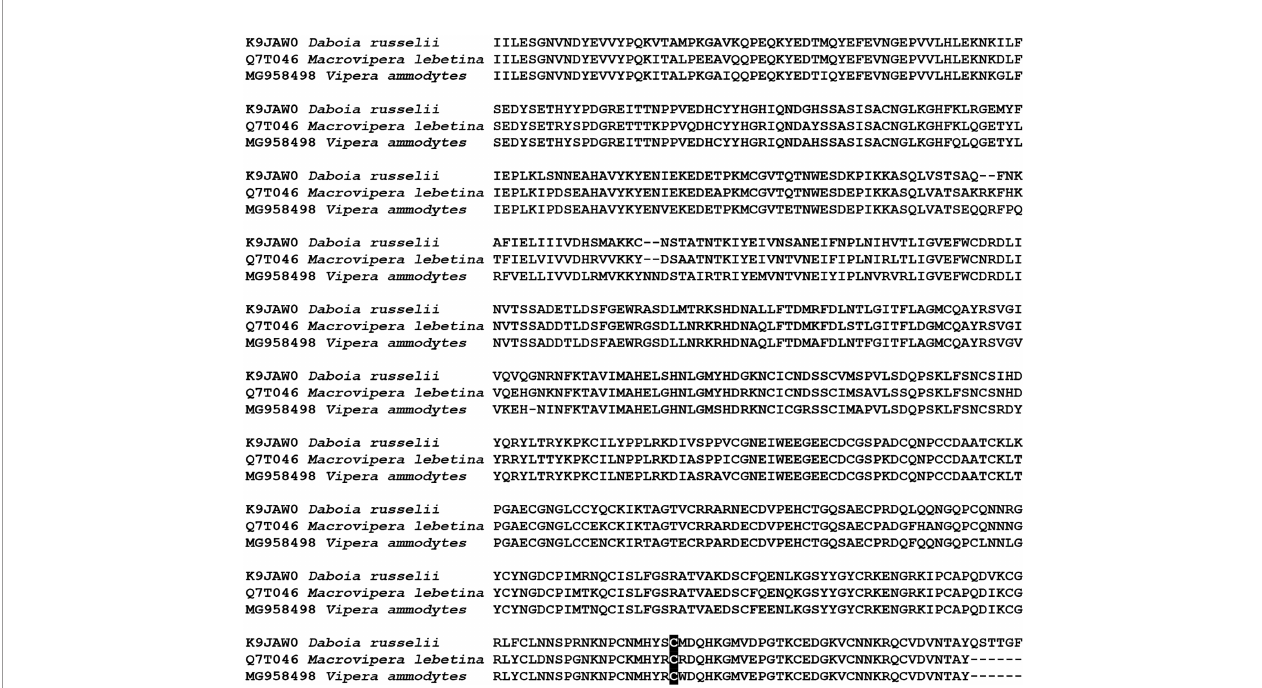
FIGURE 2 | Sequence alignment of representative Factor X activating P-IIId SVMP characteristic of the Palearctic viper clade. Highlighted is the diagnostic cysteine that forms the interchain disul fi de bond to a covalently linked lectin dimer. Uniprot ( Daboia and Macrovipera ) and Genbank ( Vipera ) accession codes are given for each